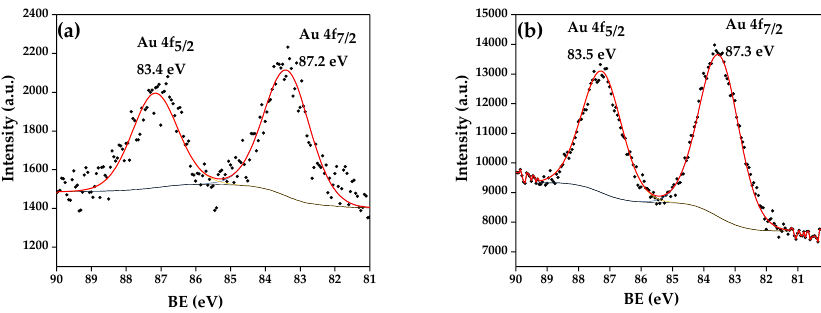
Figure 1. XPs spectra of Au 4f level of ( a ) Au/calc-Sr sup and ( b ) Au/Sr sup catalysts. The red line represents the fitted spectrum and the black one is the background.